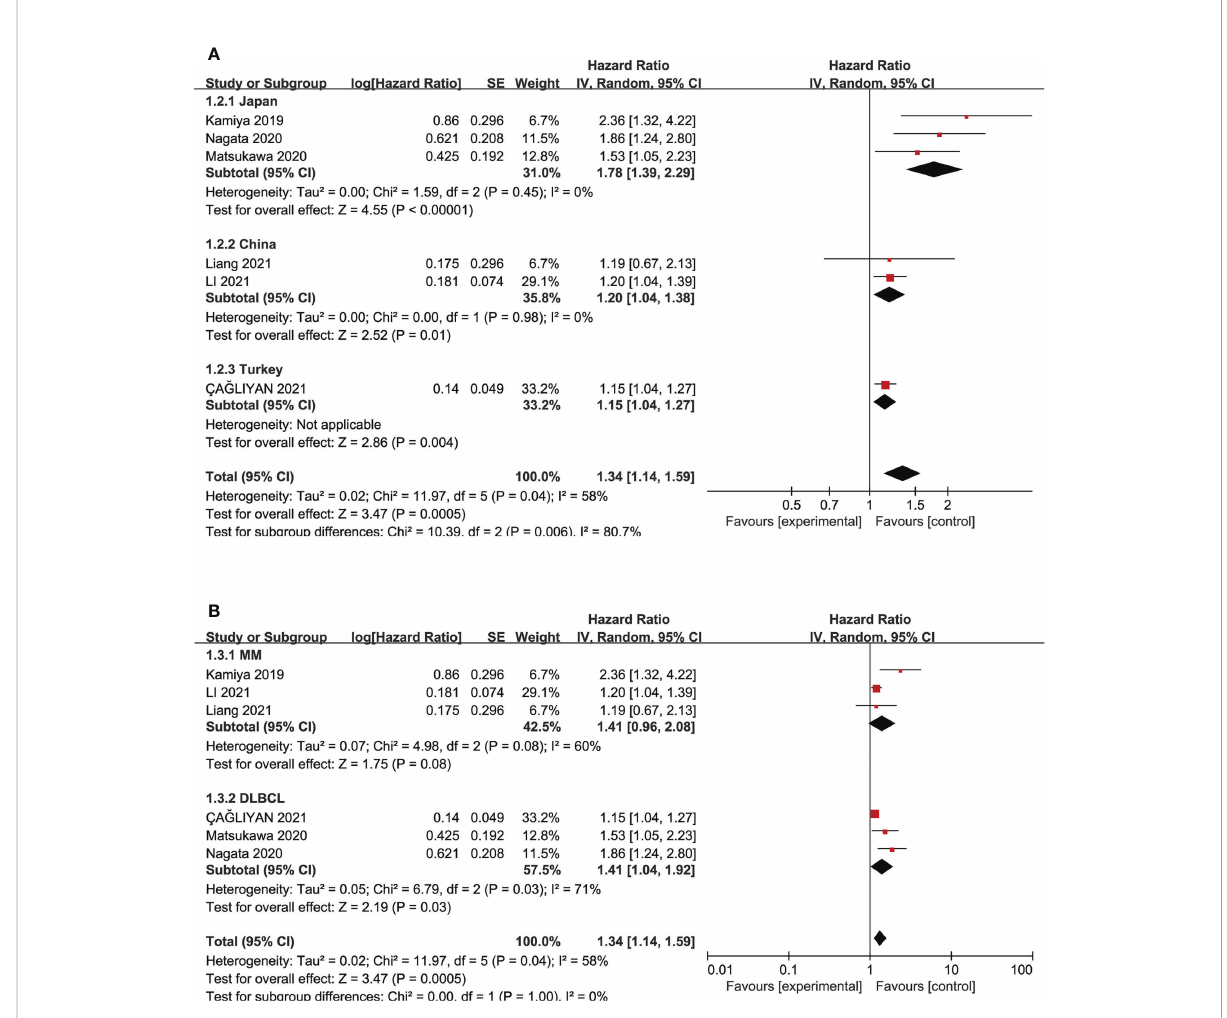
FIGURE 4 Subgroup analysis of the prognostic role of high CONUT score on OS according to their races (A) and types of hematologic malignancies (B)